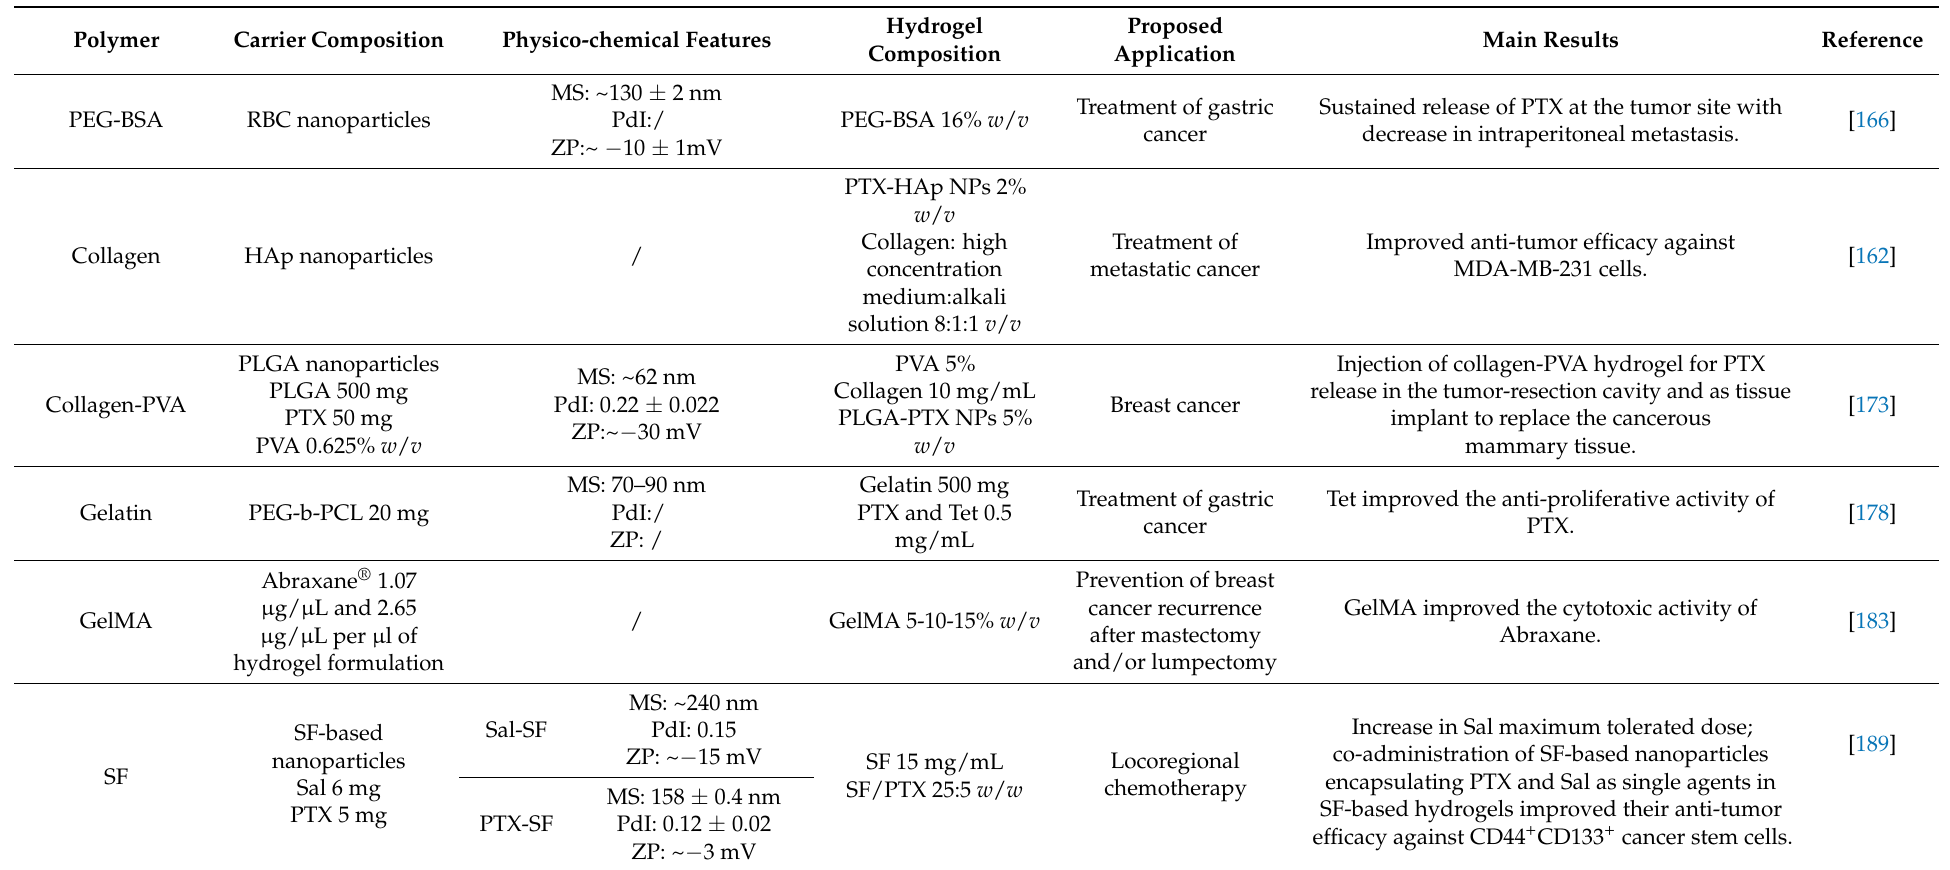
Table 2. Composition and physico-chemical features of PTX-loaded micro/nanosystems embedded in protein-based hydrogels.